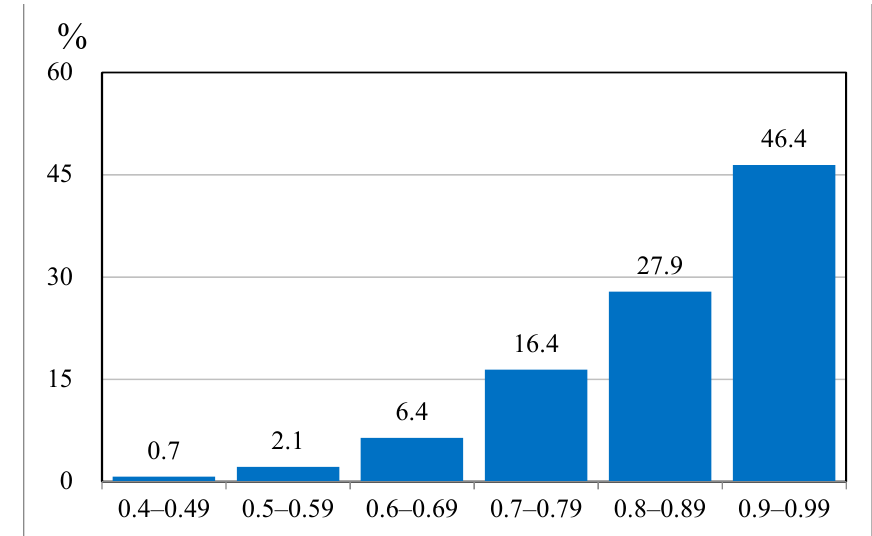
Figure 5. Distribution of group technical efficiency (GTE) scores of Current Year Harvest.